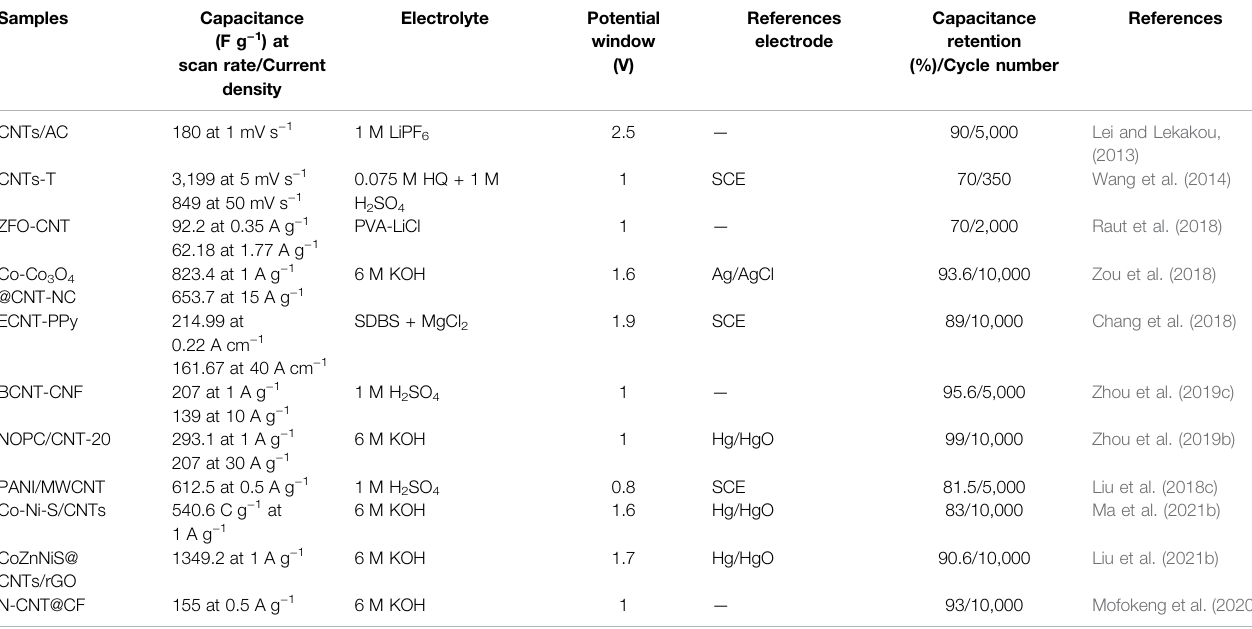
TABLE 3 | The electrochemical performance of carbon nanotube (CNT) nanocomposites as electrodes for SCs.